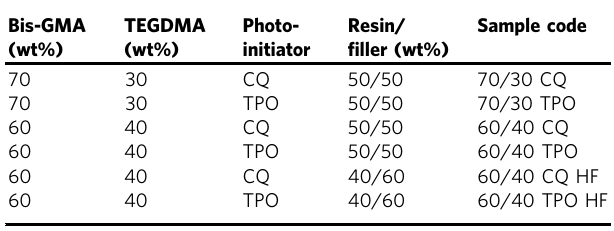
Table 1 Summary of sample composition and corresponding sample